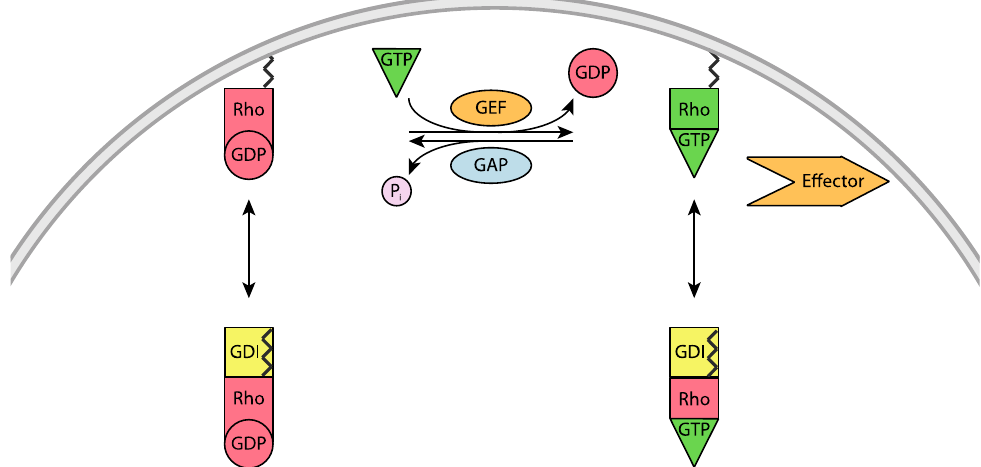
Figure 3. Rho GTPase signaling and the key regulatory proteins. Guanine Exchange Factors (GEFs) activate Rho (green) by mediating the exchange GDP for GTP, while GTPase Activating Proteins (GAPs) promote Rho’s intrinsic GTPase activity, hydrolyzing GTP to GDP and leading to inactivated Rho (red). Guanine Dissociation Inhibitors (GDIs) associate with the covalently bound lipid groups (indicated as jagged black lines) promoting Rho’s dissociation from the membrane. A downstream effectors is coloured orange, and is intended to indicate a range of proteins including ROCKs.